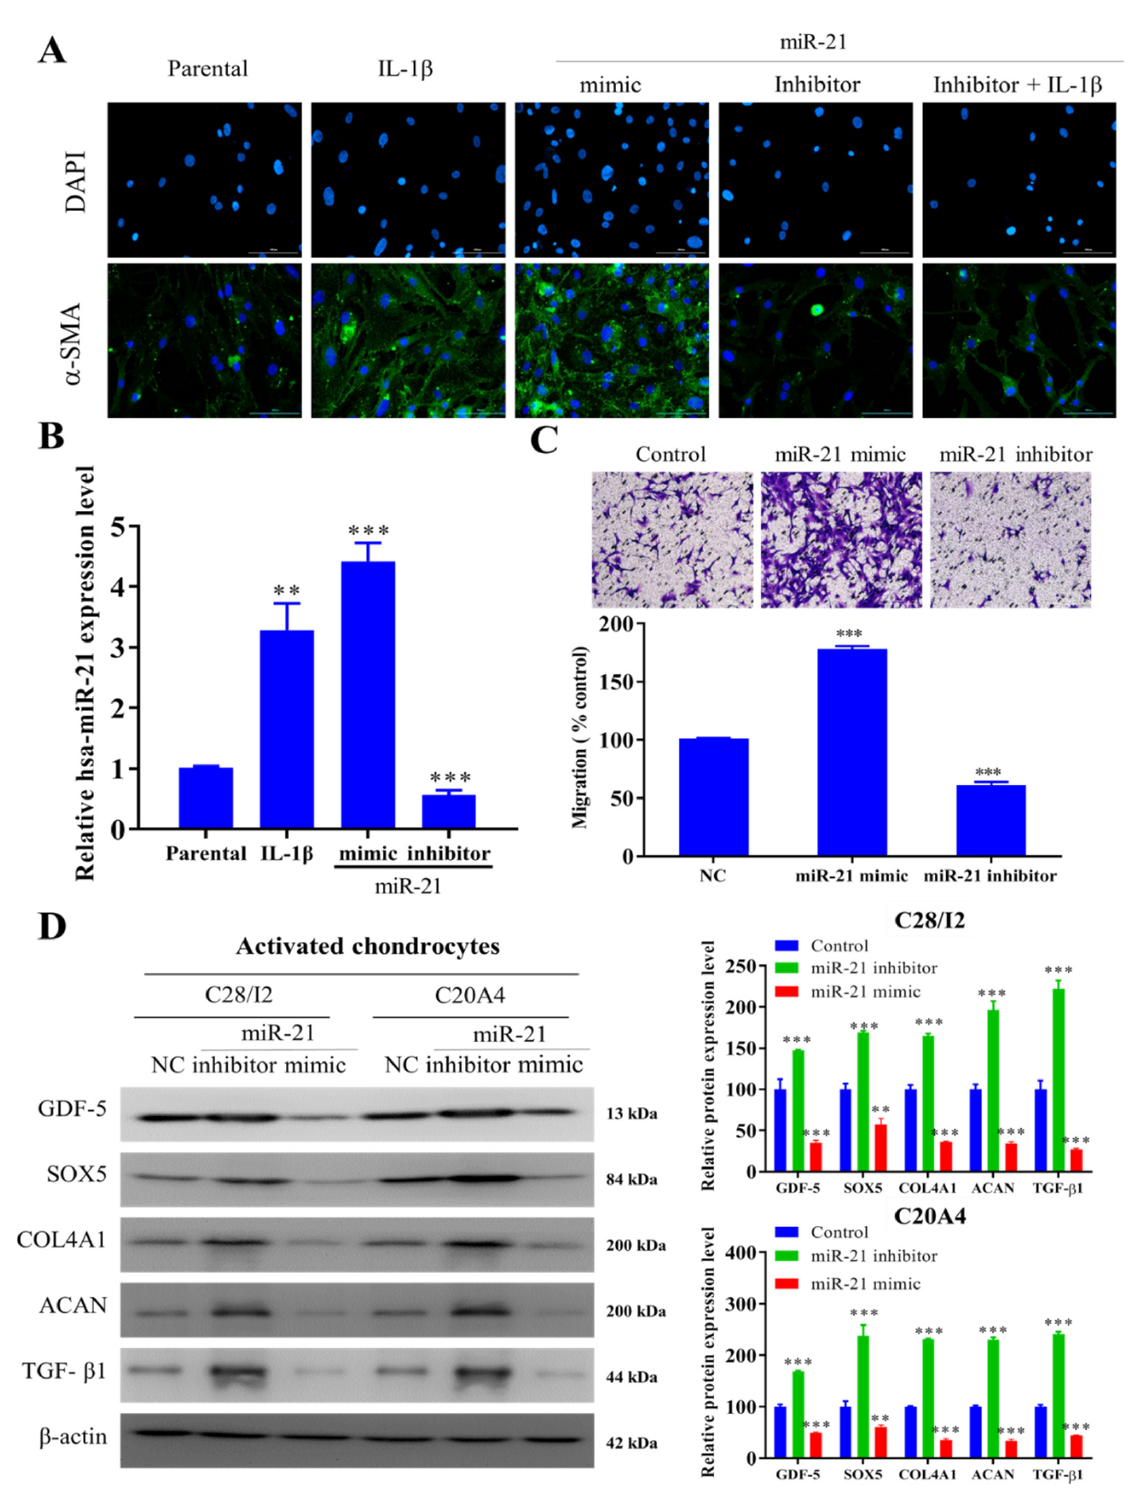
Figure 2. In-vitro inhibition of miR-21 checks the synovial fibroblast transformation. ( A ) Representative immunofluorescence image demonstrating the effects of miR-21 inhibition and overexpression on α -SMA expression in the presence or absence of IL-1 β in SW982 cells. ( B ) qRT-PCR analysis of miR-21 expression after inhibition (Inhibitor), overexpression (Mimic), control (NC), and stimulation by IL-1 β . ( C ) Representative image of cells after 24-h treatment demonstrating the effect of miR-21 on cellular motility. ( D ) Western blot and bar chart demonstrated protein expression of chondrogenic markers after miR-21 inhibition/overexpression to evaluate the effect of coculturing SW982 cells (AFs) with chondrocytes (C28/I2 and C20A4). Scale bar = 50 µ m. ** p < 0.01 and *** p <